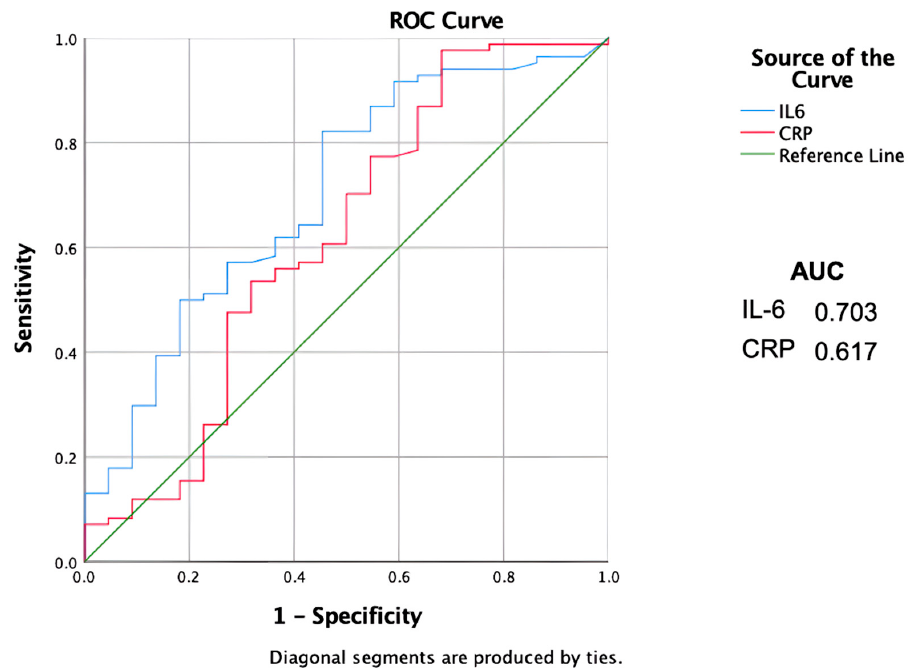
Figure 1. ROC curves showing sensitivity and specificity of the inflammatory biomarkers. AUC = Area Under the Curve. Il-6 = Interleukin 6. CRP = C-reactive protein.